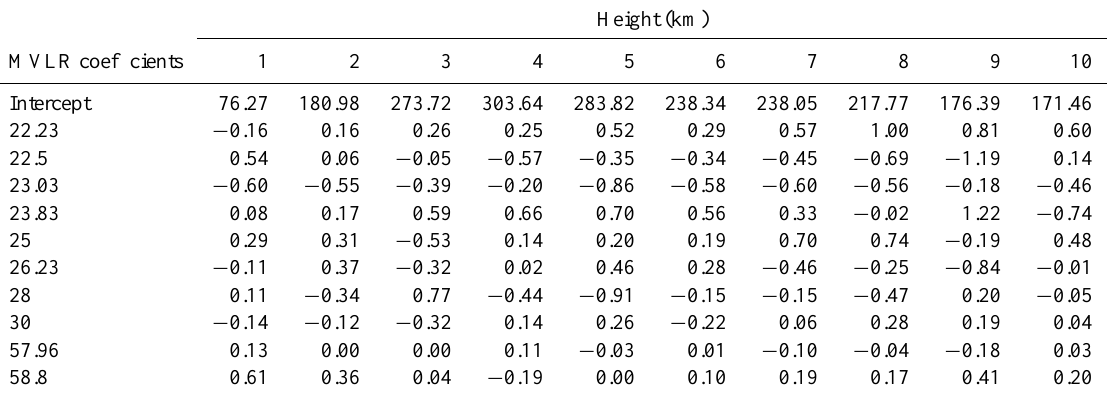
Table 1a. Multivariate regression coefficients and intercepts for temperature approximation at different height levels. Coefficients are derived using rainy and non-rainy days data.